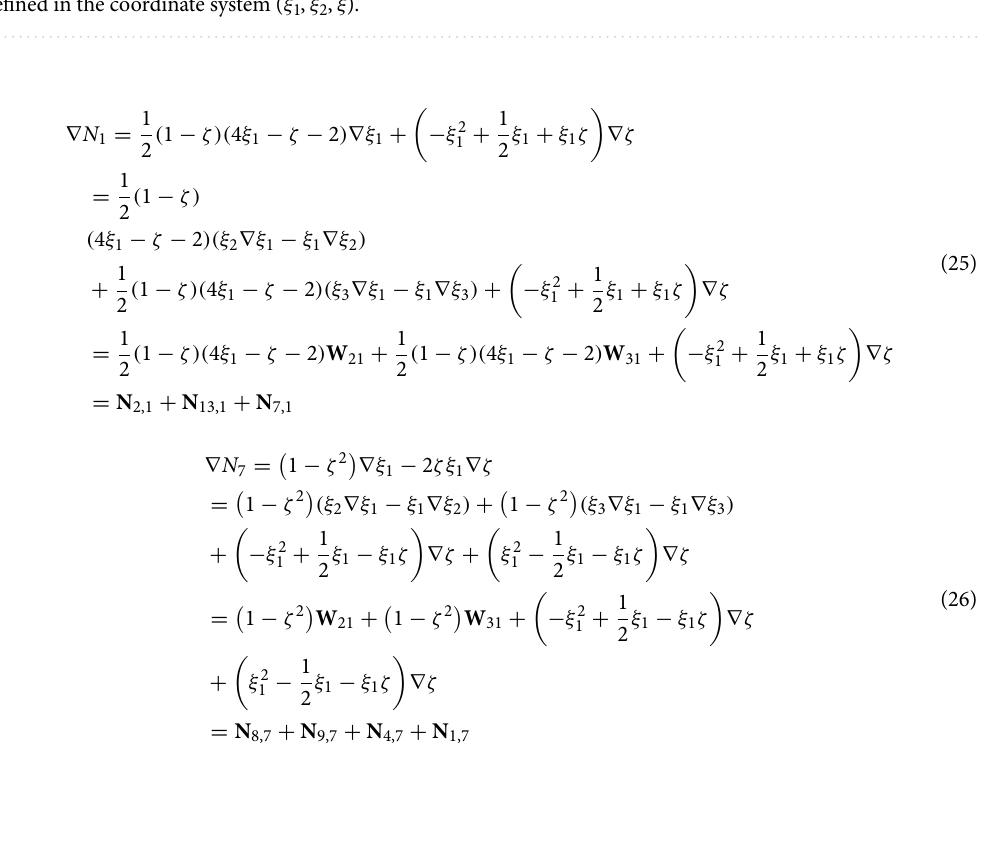
Figure 4. Illustration of one second-order triangular prism element; the serial numbers of nodes and edges are defined in the coordinate system ( ξ 1 , ξ 2 , ξ